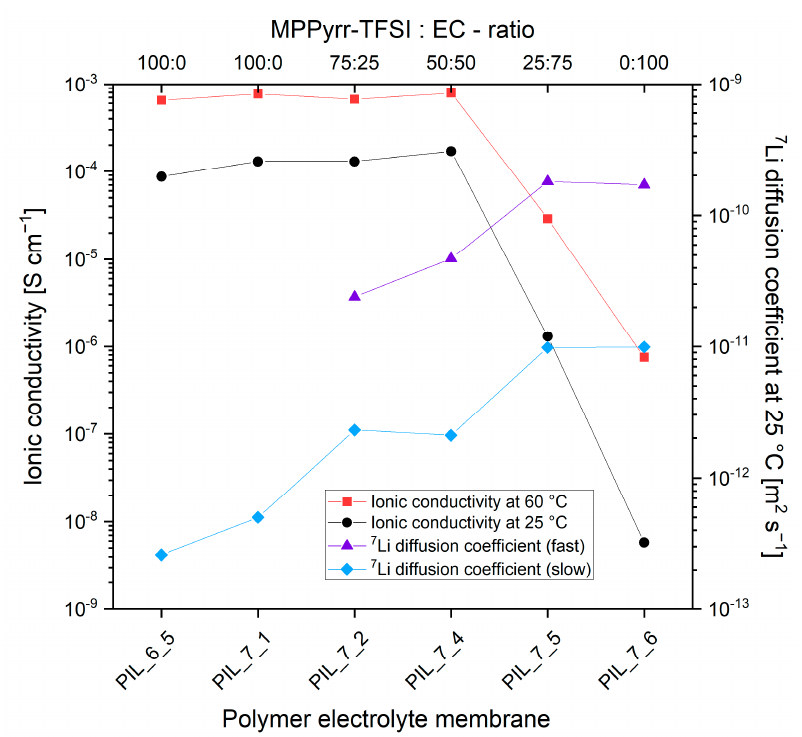
Figure 5. Dependence of the ionic conductivity values and 7 Li diffusion coefficients at 25 °C on the monomer structure and the composition of the liquid electrolyte. The two appearing 7 Li diffusion coefficients in case of ethylene carbonate containing materials are labeled as slow and fast. The points were connected for better visualization. Standard deviation of the ionic conductivity values are 17.2% and the systematic error is 2.7%. Error of the measurement is 5.6%.